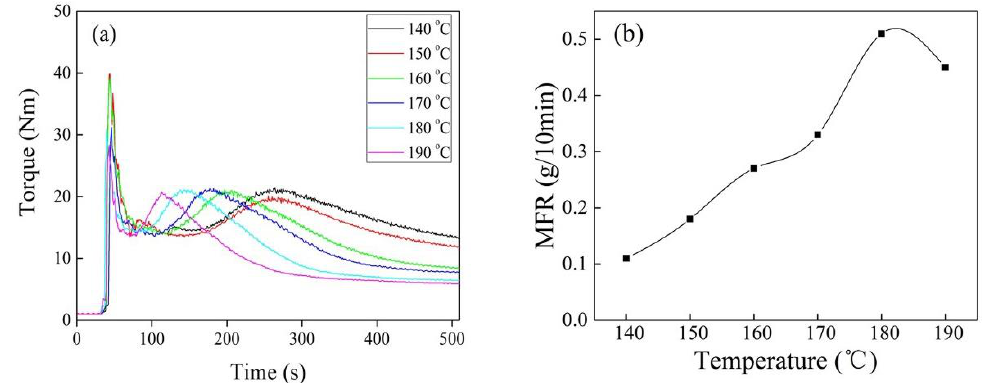
Figure 3. Torque/time spectra ( a ) and MFR ( b ) of iPB-g-MAH at different reaction temperature . (DCP = 0.6 phr, MAH = 6 phr, DVB/MAH = 4:6.)